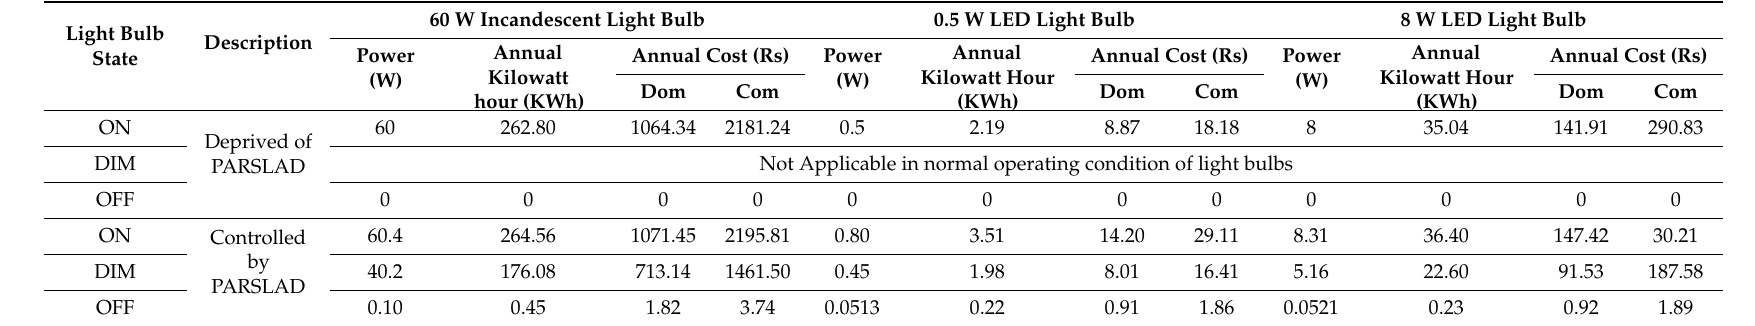
Table 7. Power and cost analysis of 60 W incandescent, 8 W LED and 0.5 W LED light